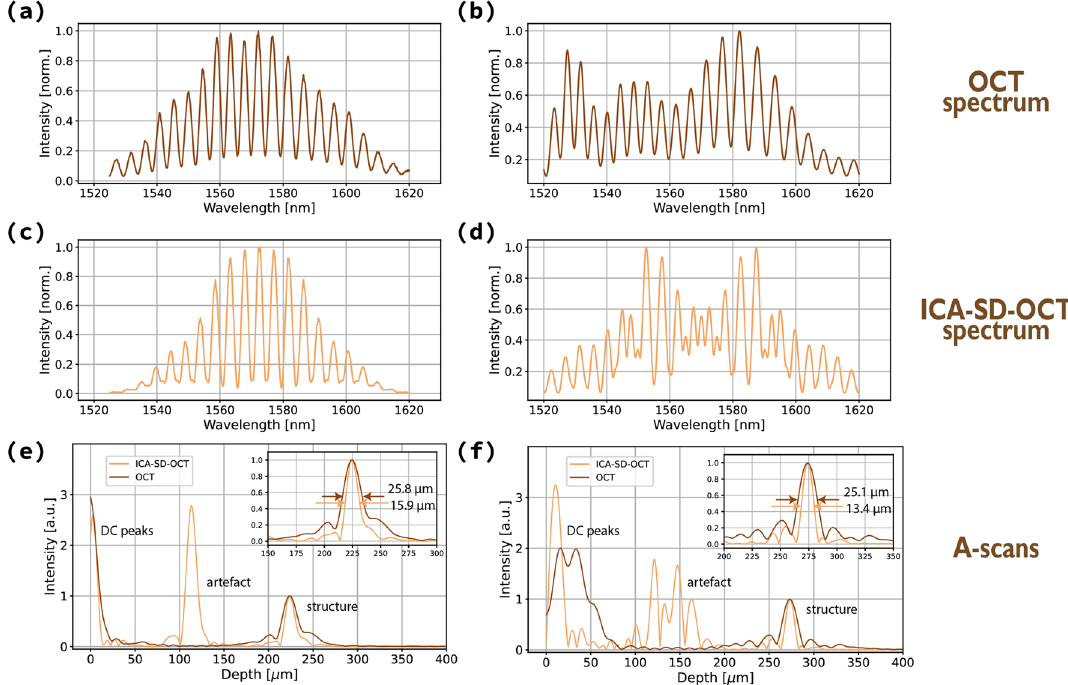
Figure 3. Experimentally measured Gaussian-like spectrum ( a ) and square-like spectrum ( b ). The results of transformation according to formula (2) depicted in panels ( c , d ), were Fourier transformed to produce A-scans (light brown in e , f ) with a better axial resolution than A-scans corresponding to the original OCT spectra (dark brown in e , f ). The insets with a zoom-in on the structural peaks show a 1.62 axial resolution increase in the case of the Gaussian-like profile, and a 1.87 increase in the case of the square-like profile. A difference in the shape of DC peaks and artefacts between ( e ) and ( f ) are due to different dispersion imbalance in the interferometer at the time of measurements. The theoretical axial resolution for both spectra—calculated as the full width at half maximum of the DC peak corresponding to raw OCT spectrum—is 25 μm for ( a ) and 24.1 μm for ( b